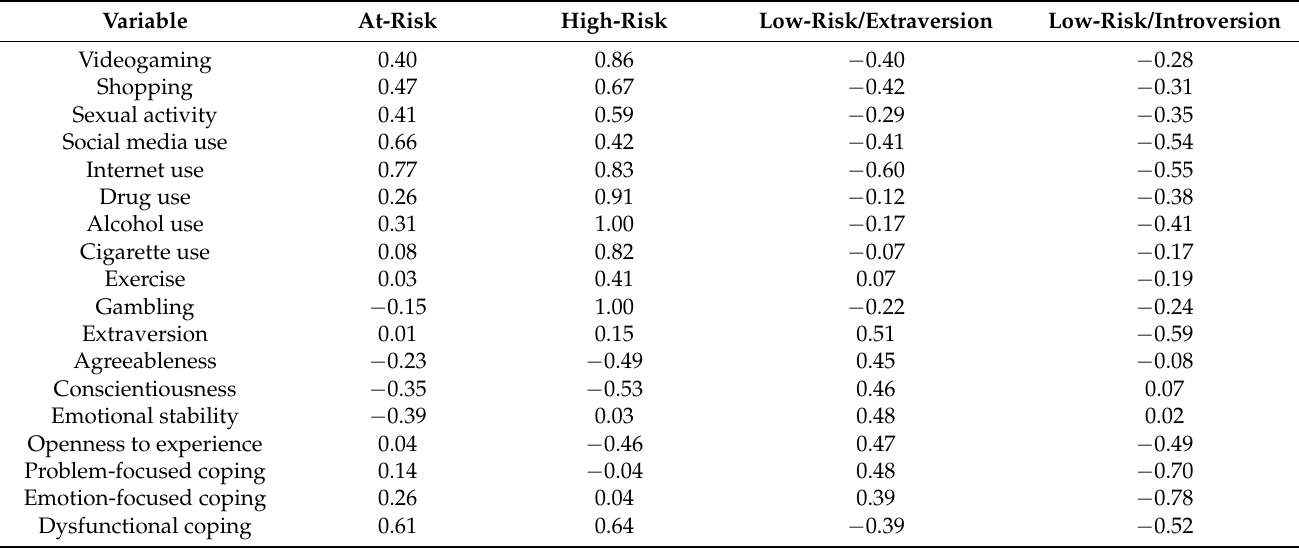
Table 3. Standardised score from the sample mean in the United Kingdom